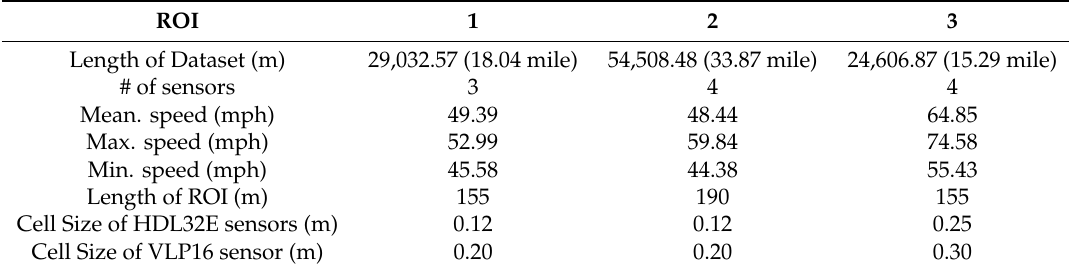
Table 5. Data acquisition specifications, extent of point cloud regions, and cell size for HDL32E and VLP16 LiDAR units for intensity normalization map generation for the three